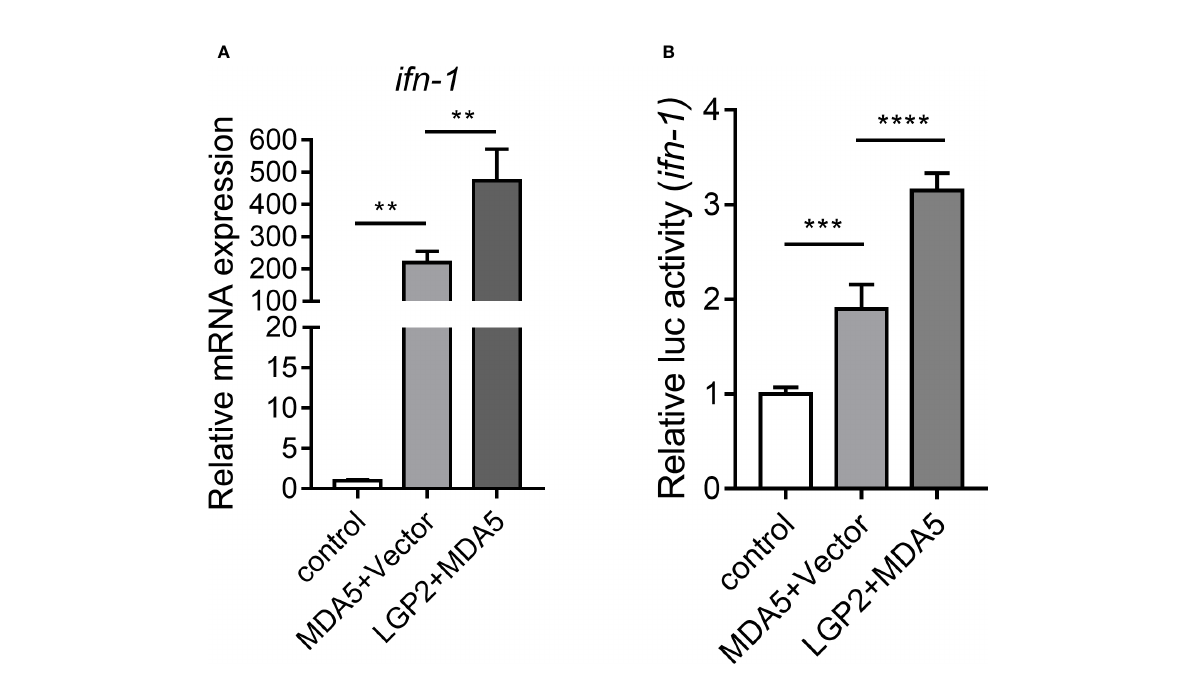
FIGURE 6 Cc LGP2 activates the Cc MDA5-inducing ifn-1 . (A) Empty vector or FLAG-tagged Cc MDA5 plasmid was co-transfected with GFP-tagged Cc LGP2 plasmid into EPC cells for 24 h. Total RNA was extracted to detect ifn-1 . Data are represented as fold induction relative to the transcriptional level in control, which was set to 1. (B) 293T cells were co-transfected with expression vectors for Fire fl y luciferase reporter gene with ifn-1 promoter, Renilla luciferase and target gene for 48 h. The relative activity of ifn-1 was the ratio of Fire fl y fl uorescence to Renilla fl uorescence. Mean ± SD (n = 3). Each experiment was conducted thrice. **P < 0.01, ***P < 0.001 and ****P <